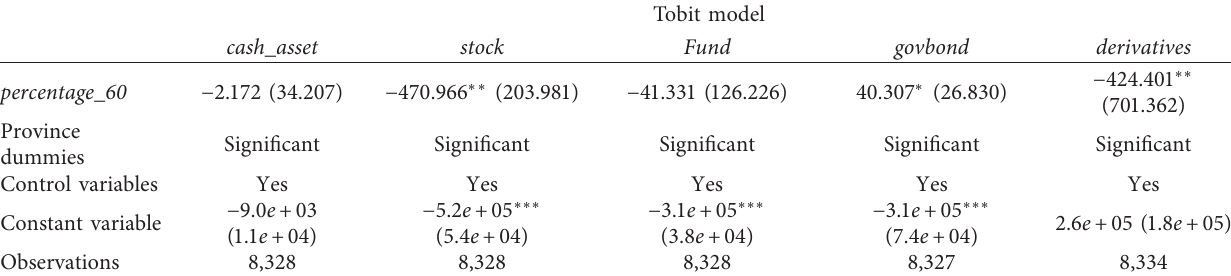
Table 9: Results on the scales of different types of financial assets.